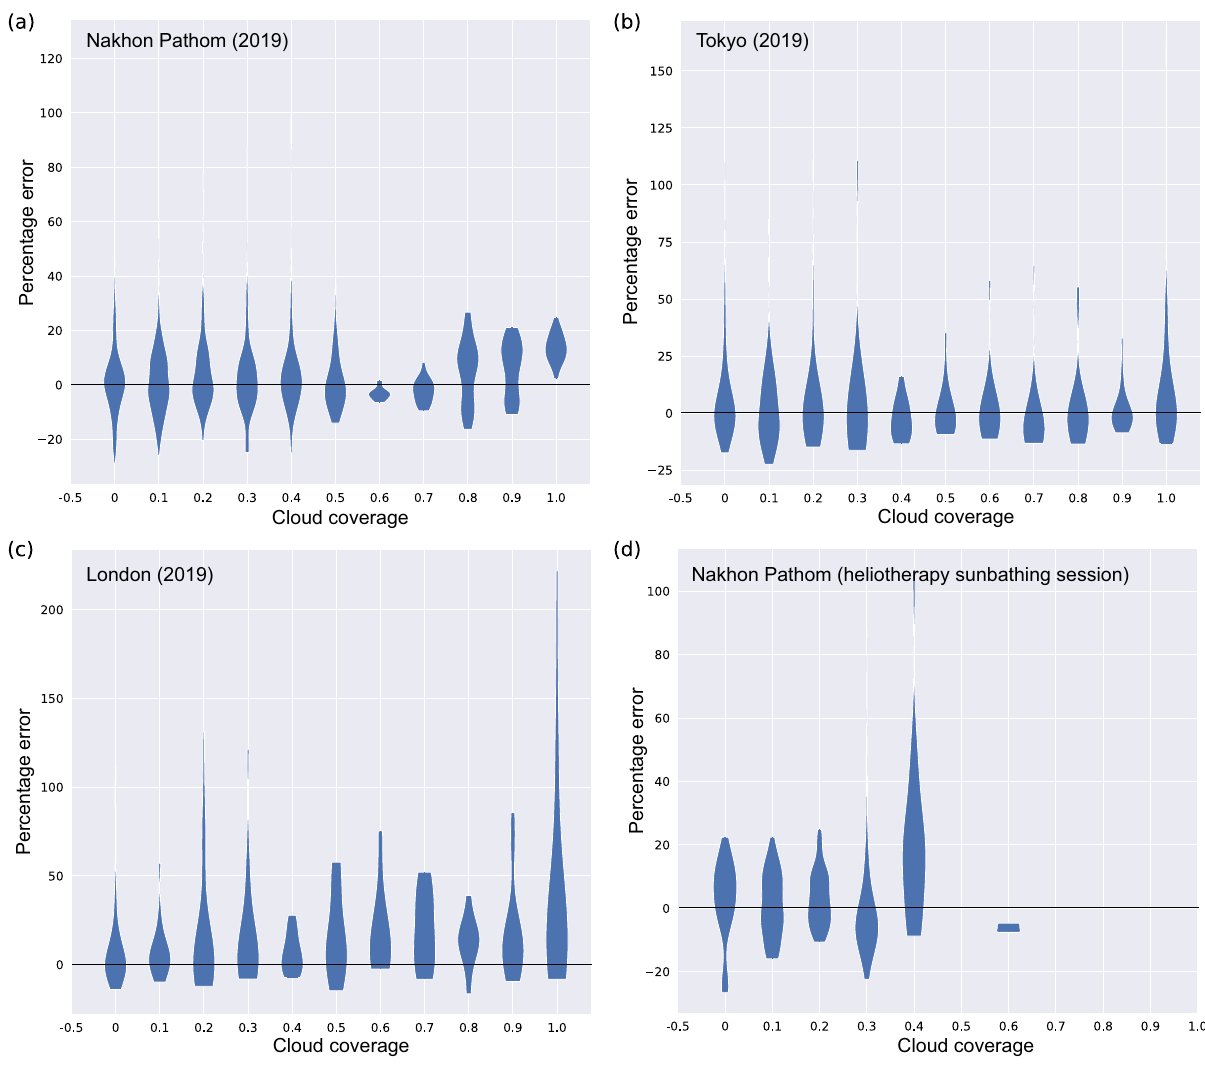
Figure 4. SurfUVNet’s forecast error weakly correlates with cloud coverage. Violin plots showing the distribution of SurfUVNet’s forecast error in 1-h interval with various cloud coverage. Errors on the test sets (UV data from year 2019) are shown. ( a ) Nakhon Pathom dataset. ( b ) Tokyo dataset. ( c ) London dataset. ( d ) Heliotherapy sunbathing sessions planned by photodermatologist at King Chulalongkorn Memorial Hospital. Each data point that constitutes the violin plots correspond to the error between predicted and actual antipsoriatic irradiances that a patient would be exposed to if he or she were to sunbath according to dermatologist’s